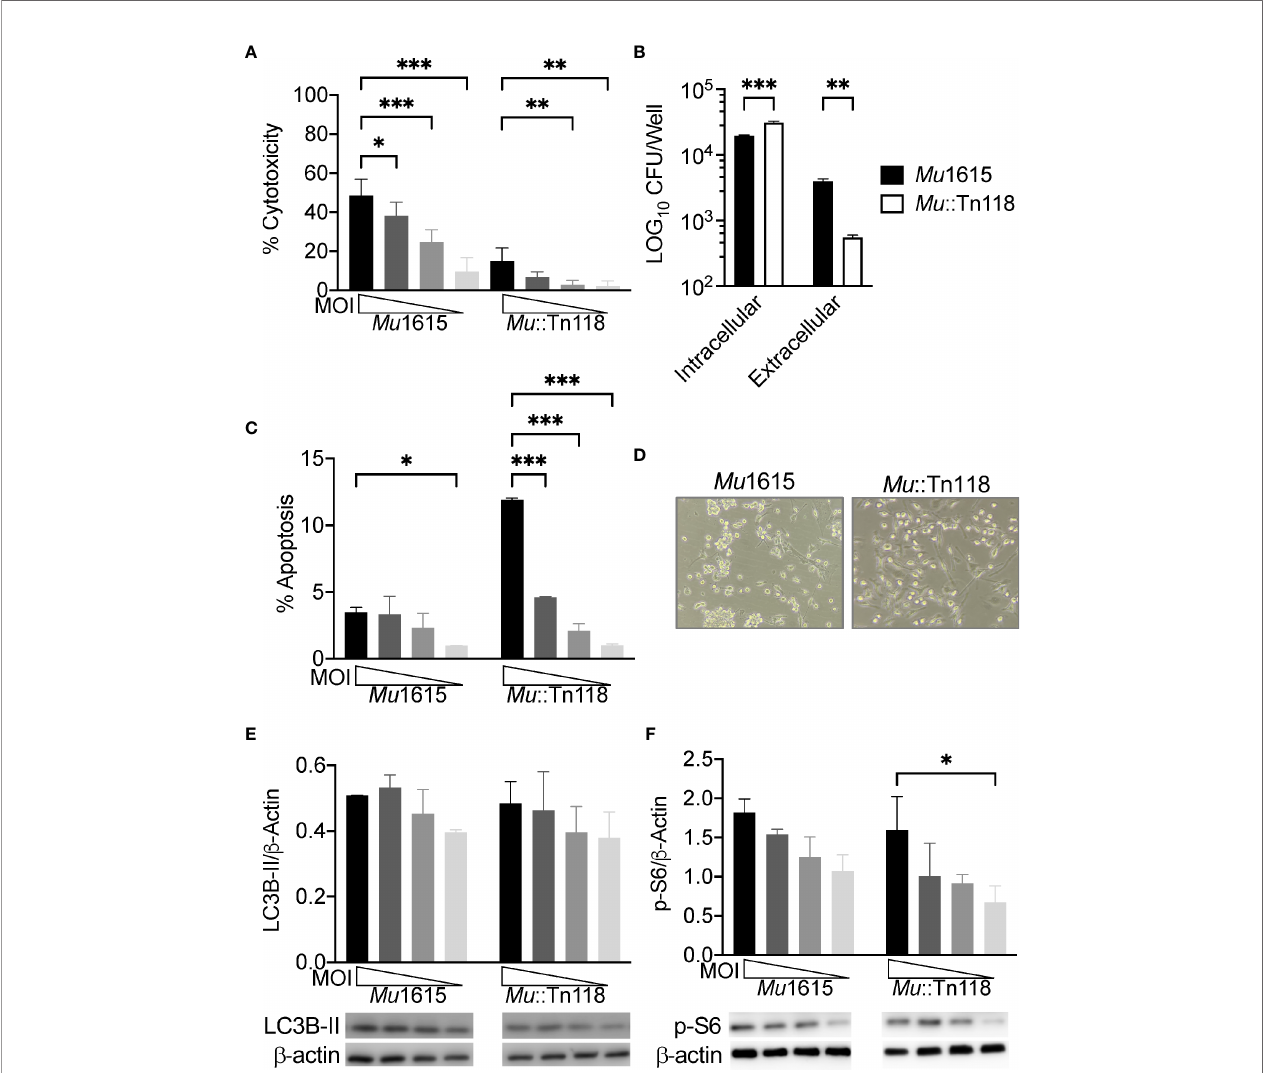
FIGURE 1 | Mycolactone competent M. ulcerans induces necrosis, allowing for bacterial egress while maintaining mTOR activation during macrophage infection. (A) BMDMs infected with Mu 1615 or Mu ::Tn118 at MOI 10, 5, 2, and 1 were measured for LDH release at 72 h postinfection. (B) BMDM culture supernatant and cell lysate were plated for CFU enumeration at 72 h postinfection with Mu 1615 and Mu ::Tn118 at MOI 10. (C) Apoptosis was assayed by staining with Caspase 3/7 detection reagent in BMDMs infected with Mu 1615 or Mu ::Tn118 at MOI 10, 5, 2, and 1 at 72 h postinfection. (D) Representative bright- fi eld microscopy image of BMDMs infected with Mu 1615 or Mu ::Tn118 at MOI 10, 72 h postinfection. Immunoblots were assayed from lysates of BMDMs infected with Mu 1615 or Mu ::Tn118 at MOI 10, 5, 2, and 1, 72 h postinfection for LC3B-II (E) or p-S6 (F) . Summary densitometric analysis was calculated by LC3B-II or p-S6 normalized to b -actin. The representative immunoblot is shown below densiometric analysis. All graphs represent one of two independent experiments with data expressed as mean ± SD. Signi fi cance was calculated by two-way ANOVA corrected by Dunnett ’ s test for multiple comparisons. *p ≤ 0.05, **p ≤ 0.01, *** ≤ p